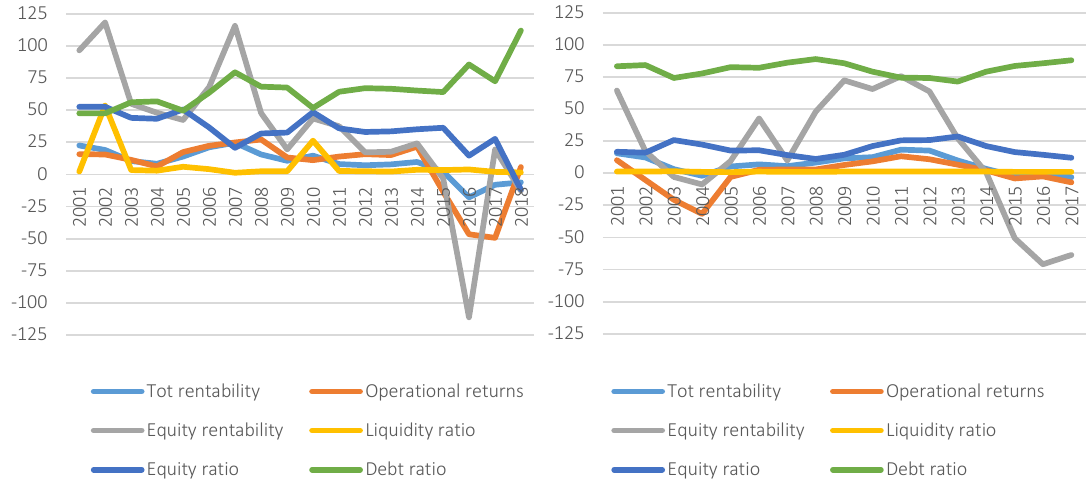
Figure 7. Key financial accounts figures for ship owning companies (left) and shipyards (right) in the BMC